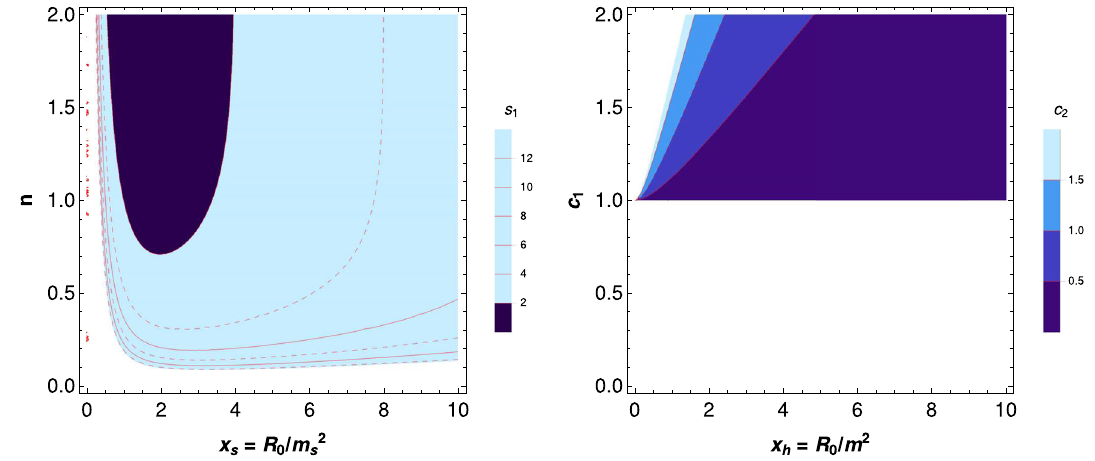
Fig. 9 Figure on left side shows the de Sitter solutions of the Starobinsky model and figure on right side shows the de Sitter solutions for the Hu–Sawicki model Similarly, for the Hu–Sawicki model, the condition for exis- tence of oscillations around stable de Sitter solutions